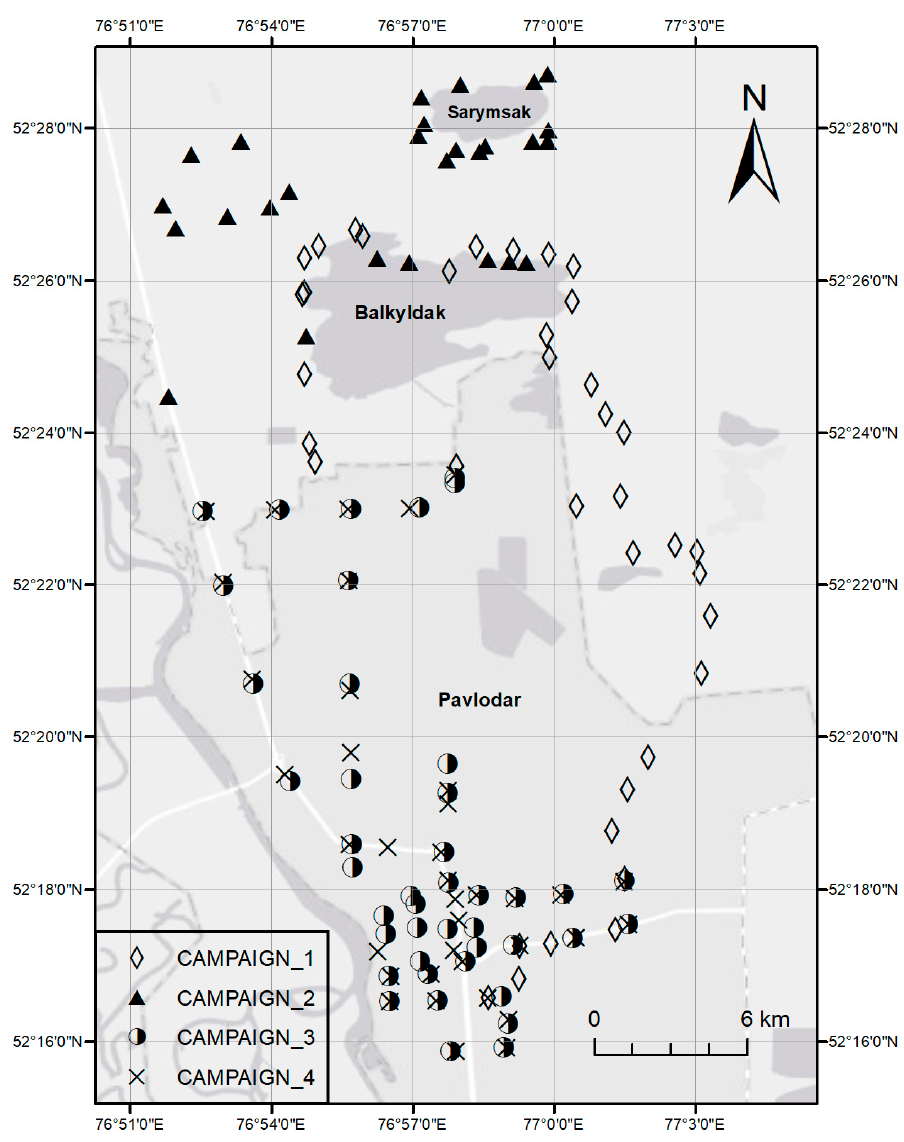
Figure 2. Sampling points of four Hg measurement campaigns: (1) July 23 (daytime), (2) July 24 (daytime), (3) July 25 (nighttime), (4) July 26 (daytime).